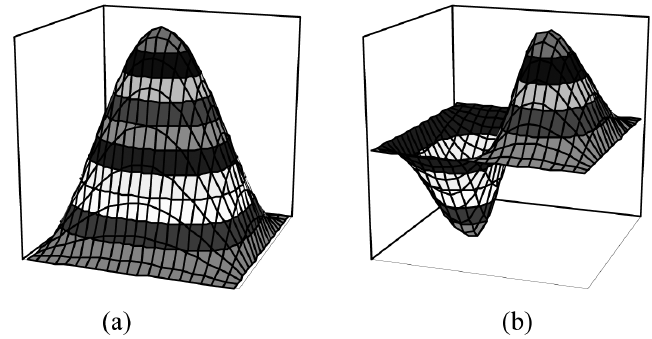
Fig. 7. The fi rst two coupled modes of a SCSC square plate with two sprung masses ( ξ 1 = 0 . 4 , η 1 = 0 . 4 , ξ 2 = 0 . 6 , η 2 = 0 . 4) . (a) the mode corresponding to Ω 1 = 19 . 027 , (b) the mode corresponding to Ω 2 = 28 . 609